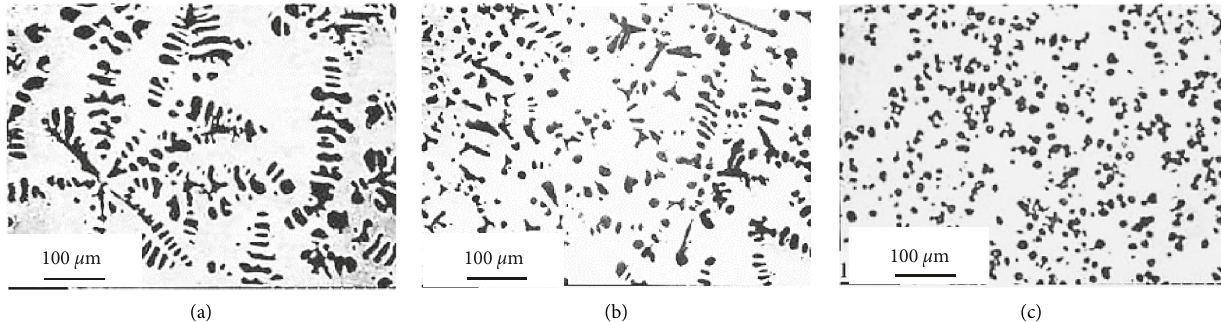
Figure 21: Microstructure of CuCr alloy prepared by vacuum induction melting. (a) CuCr25; (b) CuCr25W1; and (c) CuCr25Ni1 [23].